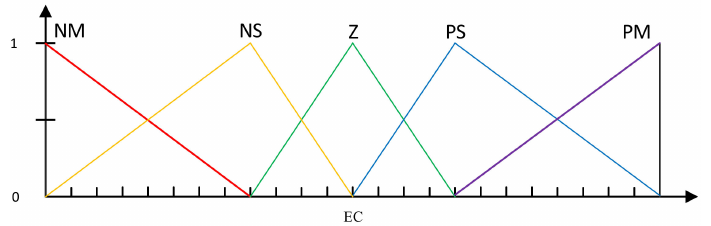
Figure 3. Electrical conductivity (EC) membership function.